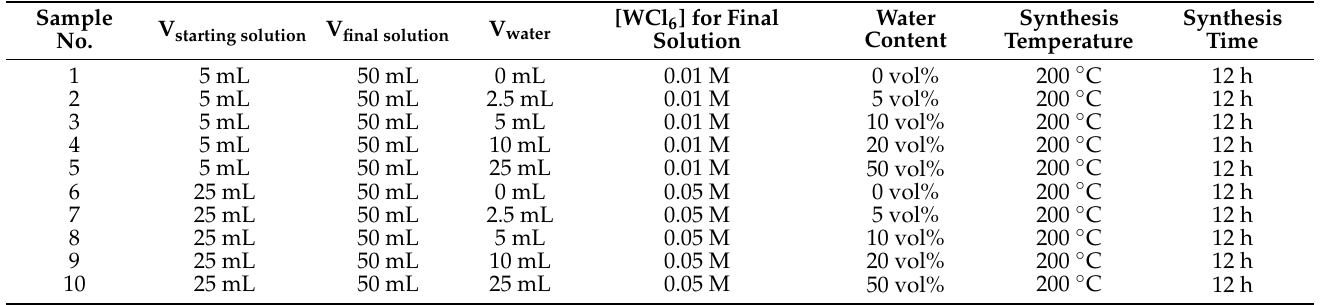
Table 2. Details of the solvothermal synthesis: list of applied synthesis temperatures and times. For convenience, we use [WCl 6 ] to denote precursor concentration.